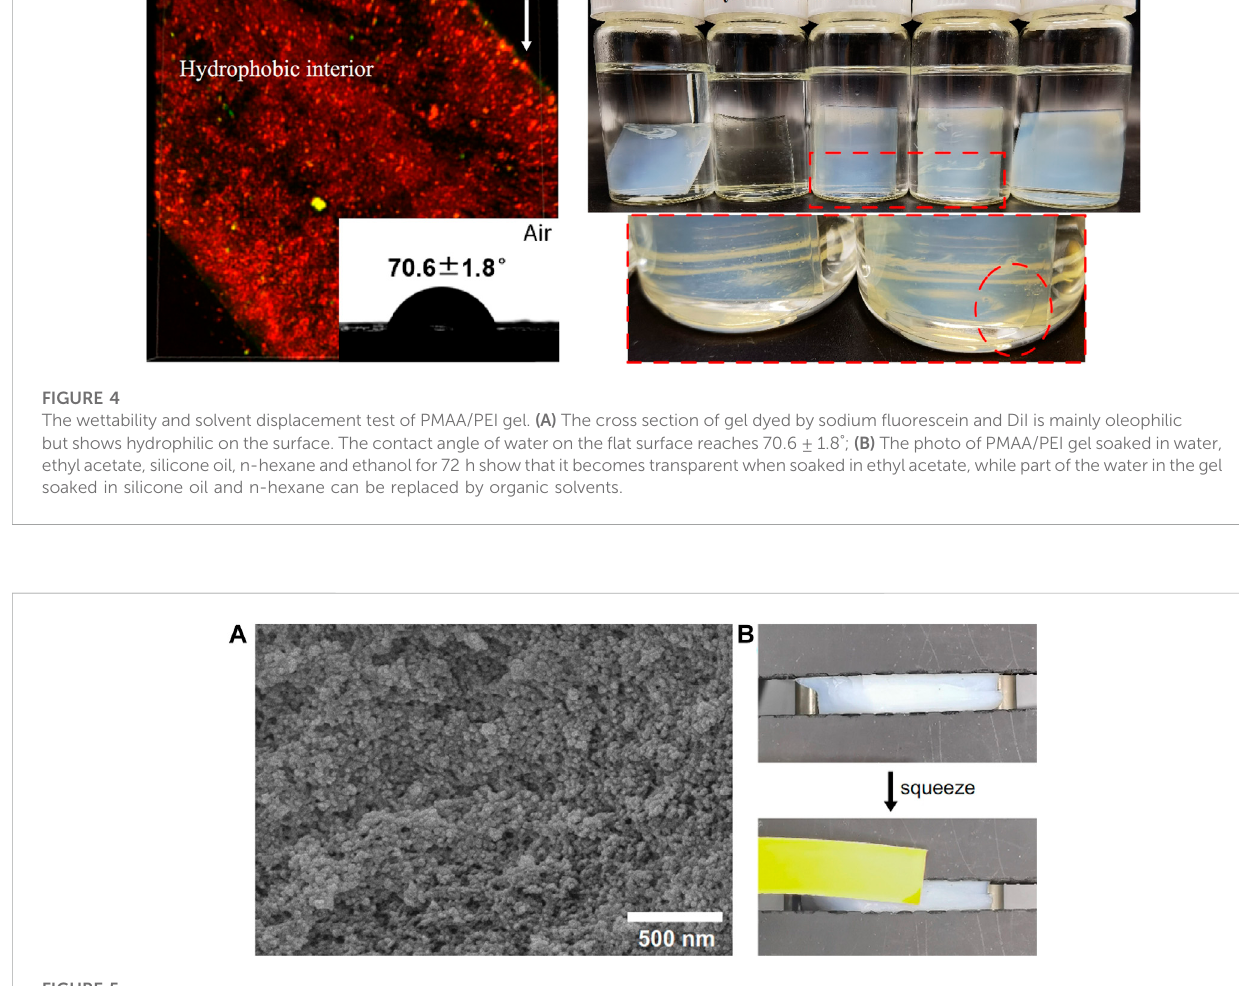
FIGURE 5 PMAA/PEI gel has a porous structure and can extrude water. (A) Porous structure of gel; (B) Under the action of external force, the water in the pore structure of gel can be squeezed